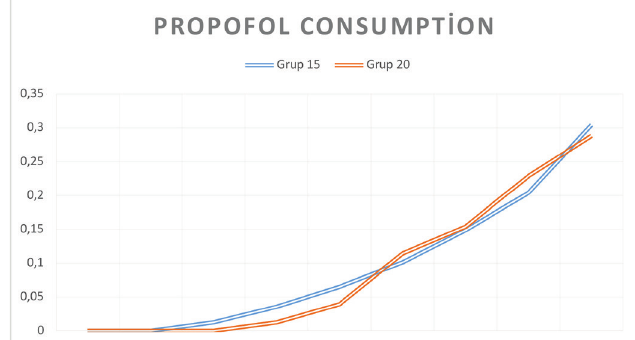
Figure 2 - The increase of the propofol consumption (mg/kg)